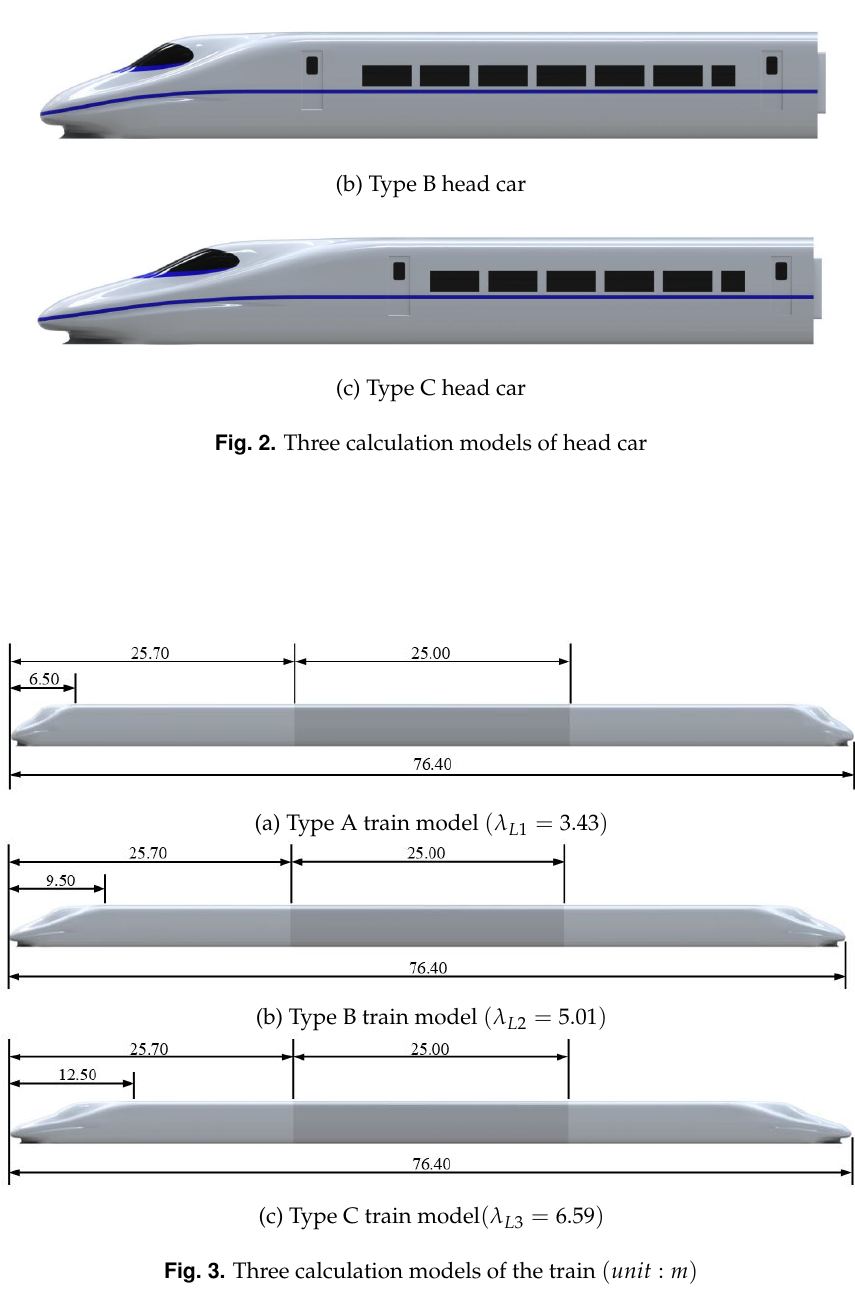
Fig. 3. Three calculation models of the train ( unit : m